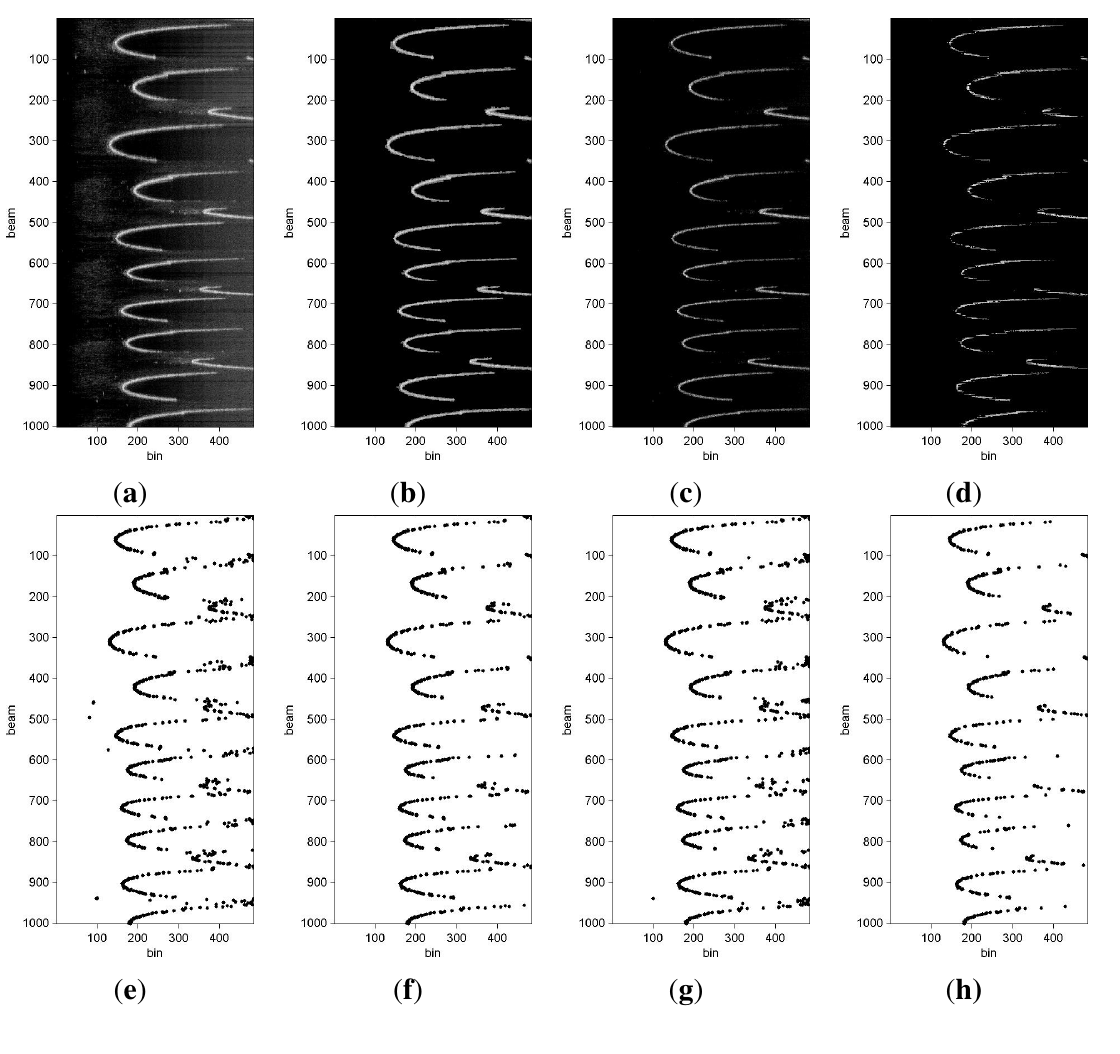
Figure 7. Beam segmentation examples with sets of acoustic images. ( a ) Original image; ( b ) Image processed with method 1; ( c ) Image processed with method 2; ( d ) Image processed with method 3; ( e ) Ranges extracted from original image; ( f ) Ranges extracted from method 1; ( g ) Ranges extracted from method 2; ( h ) Ranges extracted from method